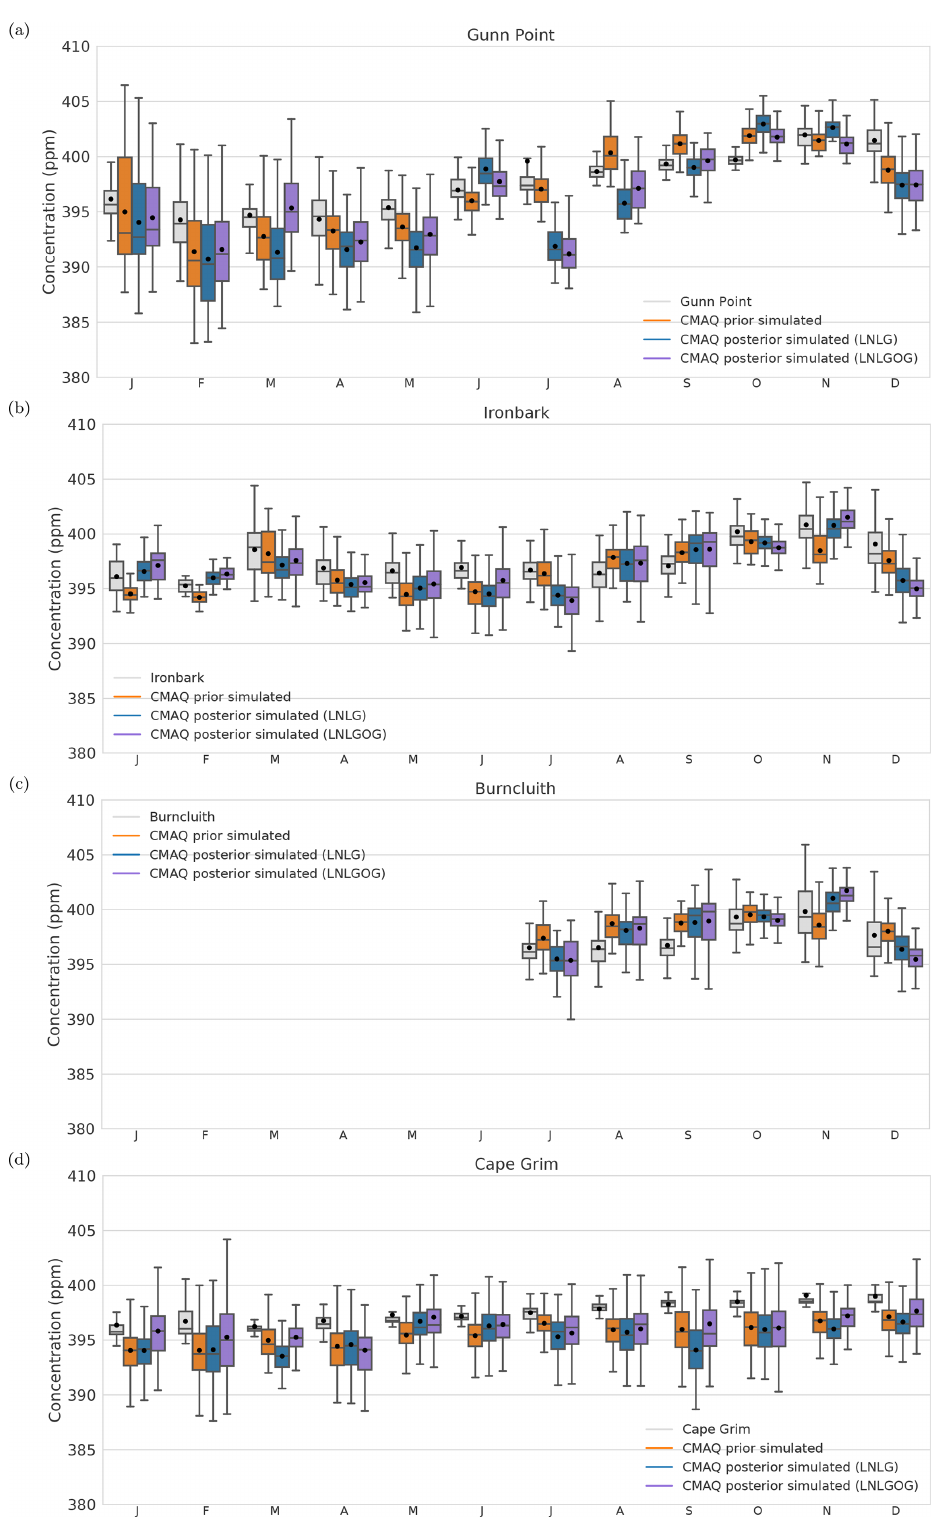
Figure 12. Box plot diagrams show the monthly mean average of CO 2 concentration at (a) Gunn Point, (b) Ironbark, (c) Burncluith and (d) Cape Grim for 2015. For details of what the different components of the box plot represent, see the caption of Fig.